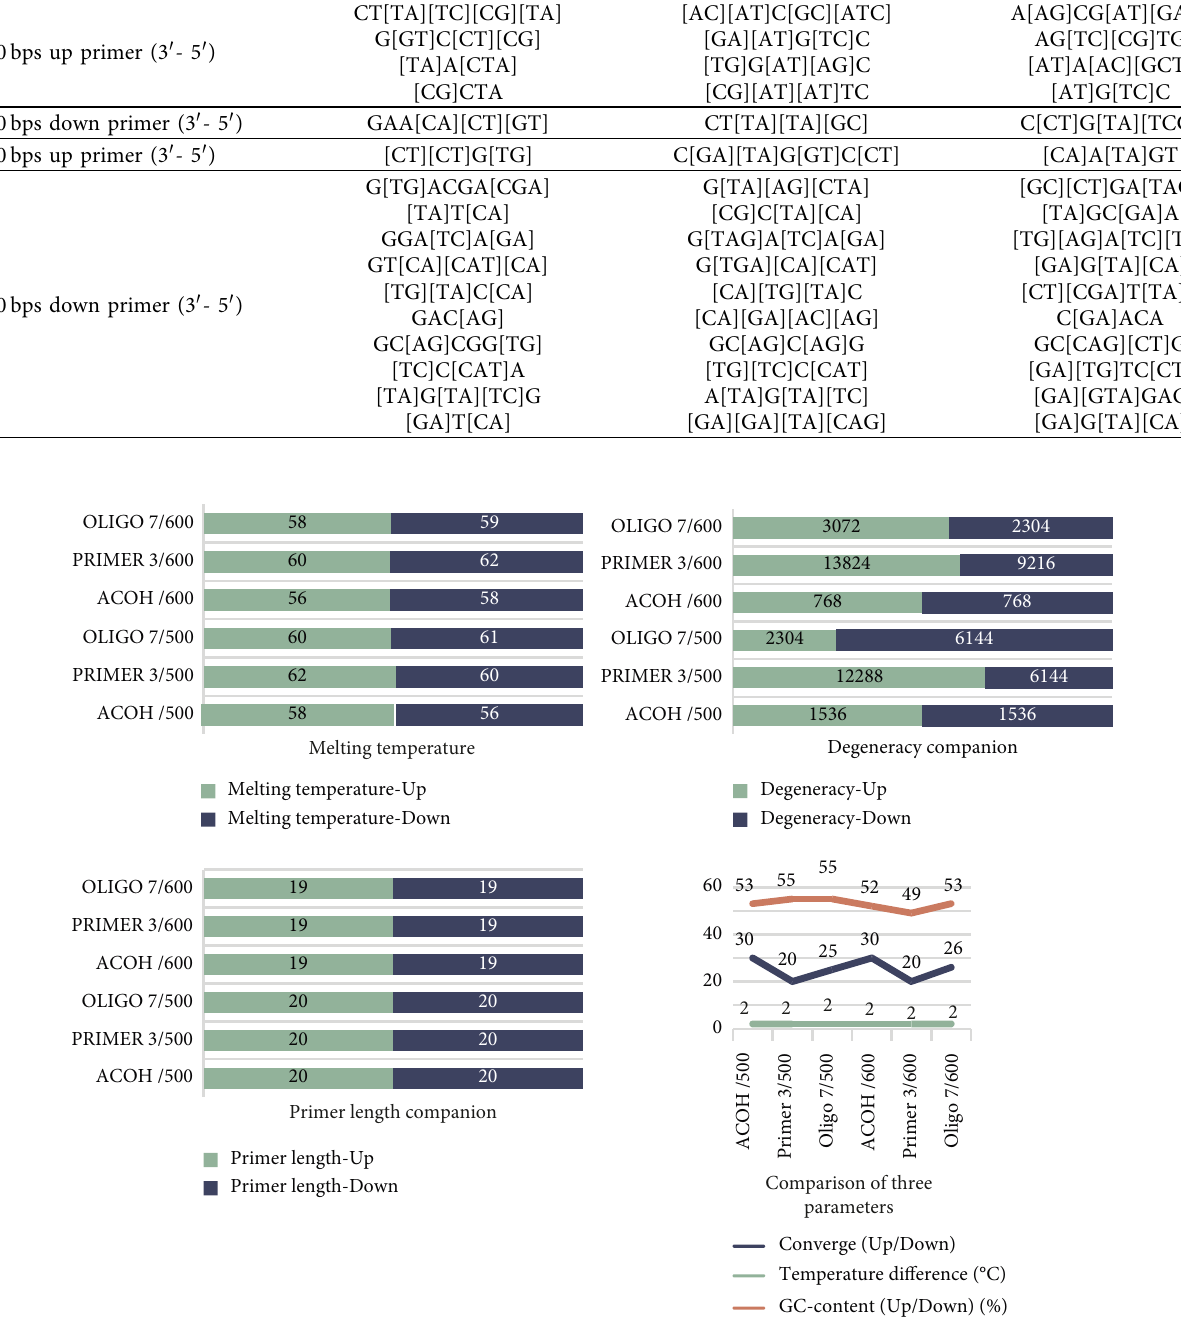
Figure 6: Comparison of four data at 500bps and 600